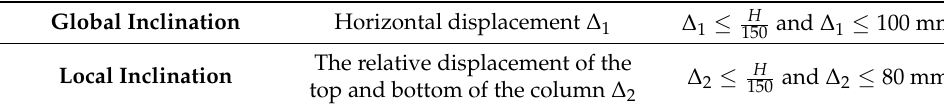
Table 3. The limitation of horizontal displacement of the timber frame.